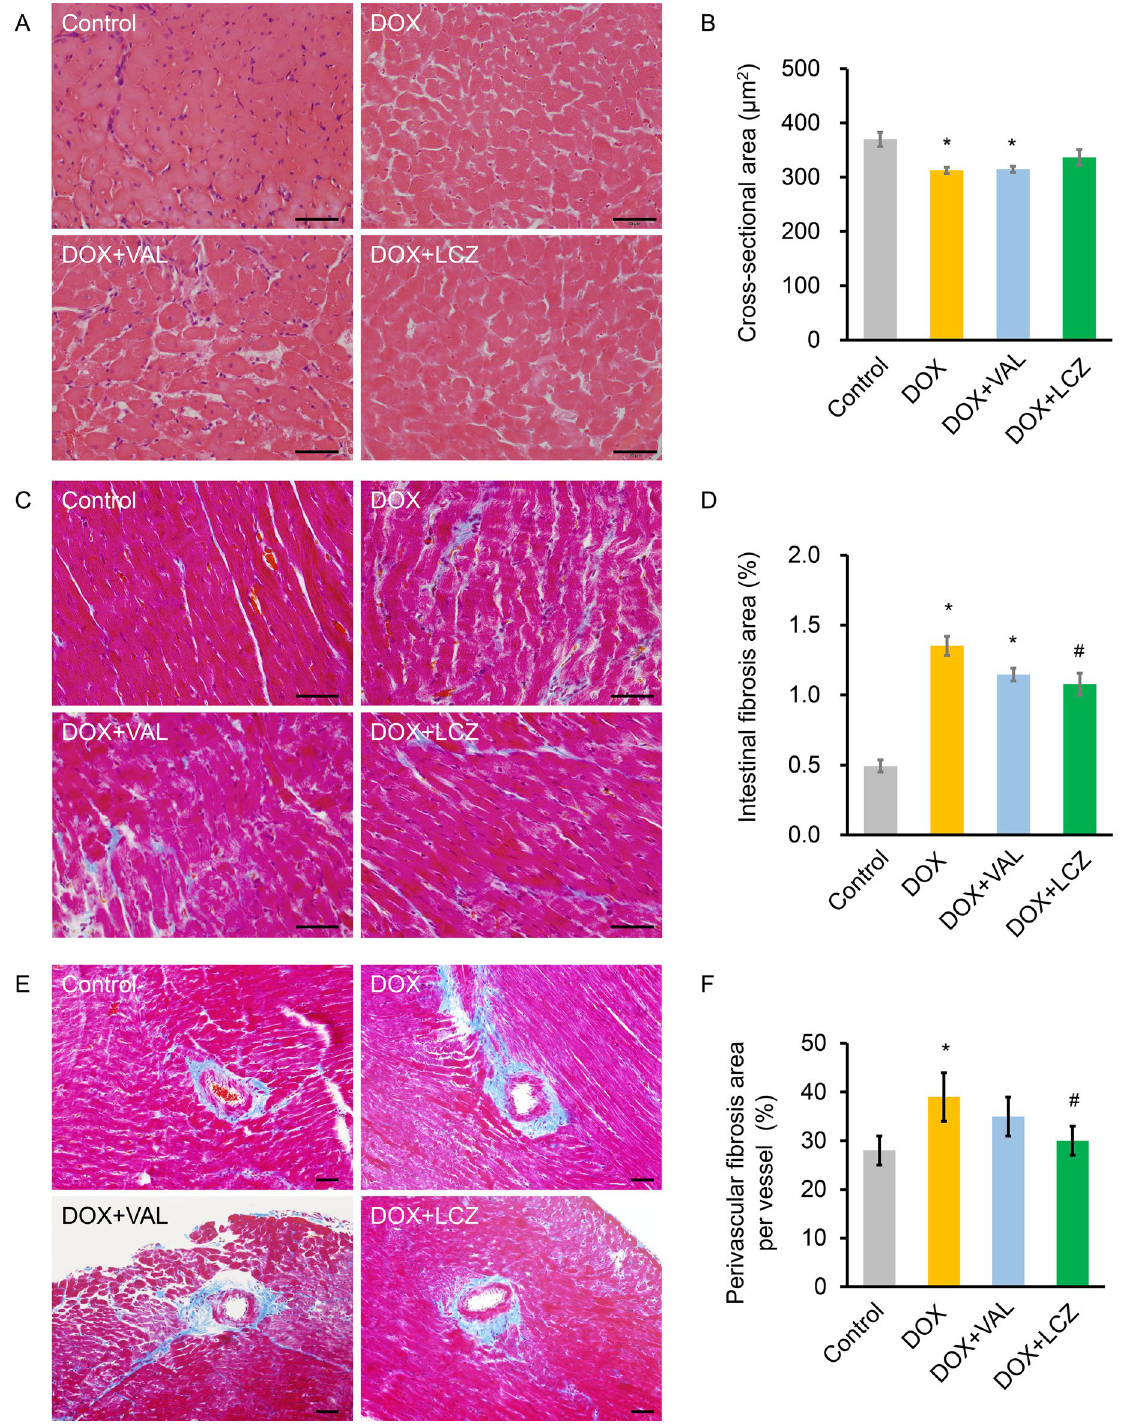
Figure 4. Effect of valsartan and LCZ696 on morphological changes in rat heart treated with doxorubicin. ( A ) Representative hematoxylin and eosin and Masson’s trichrome staining on day 18 in each group. ( B ) DOX significantly decreased the cross-sectional area of cardiomyocytes compared to the control group, whereas the increase in the cross-sectional area of cardiomyocytes by VAL and LCZ was not significant. ( C ) Representative Masson’s trichrome staining of intestinal fibrosis on day 18 in each group. ( D ) The percentage of intestinal fibrotic area was significantly increased by DOX. LCZ, but not VAL significantly reduced the percentage of intestinal fibrosis induced by DOX. ( E ) Representative Masson’s trichrome staining of perivascular fibrosis on day 18 in each group. ( F ) The percentage of perivascular fibrotic area was significantly increased upon DOX treatment. LCZ, but not valsartan, significantly reduced the DOX-induced percentage perivascular fibrotic area. Data are expressed as the mean ± standard error. Scale bars, 50 μm. Five random fields from three random samples per group were evaluated for the analysis. * p < 0.05 versus control and # p < 0.05 versus DOX. DOX, doxorubicin; VAL, valsartan; LCZ,